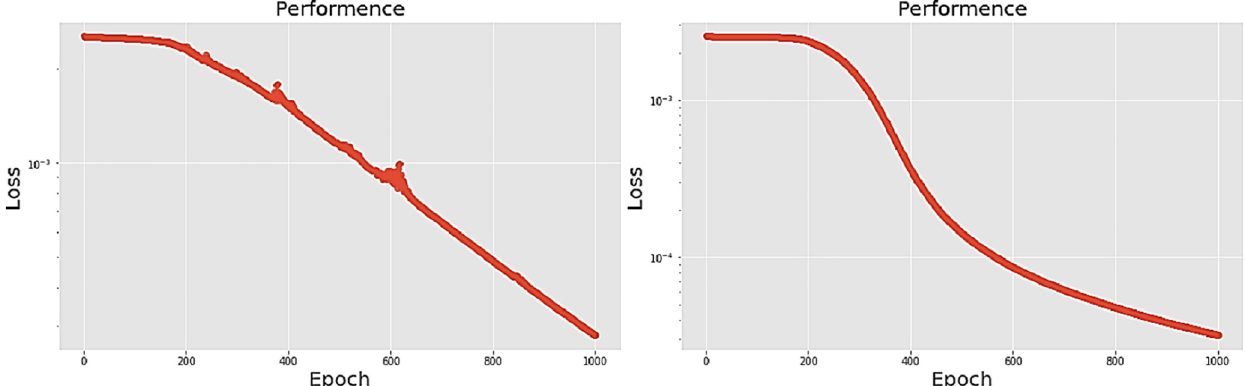
Fig 22. (a) The graph shows the performance of LPC-LSTM-2 × 300 model; (b) The graph shows the performance of LPC-PCA-LSTM-2 × 300 model.